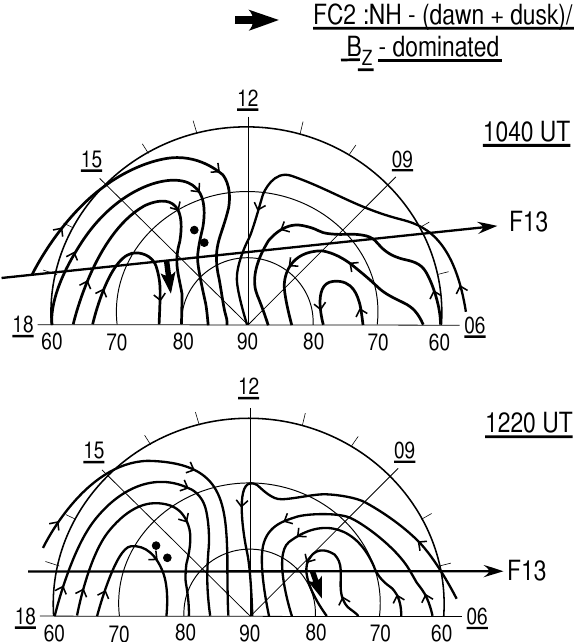
Fig. 5. Averaged convection patterns at 10:40UT (top panel) and at 12:20UT (bottom) on 25 July 2004 corresponding to the ICME magnetic field conditions observed by Wind, according to the APL- model (see Ruohoniemi and Baker, 1998). Marked by solid dots are two magnetometer stations on Svalbard (NAL-HOR). Marked